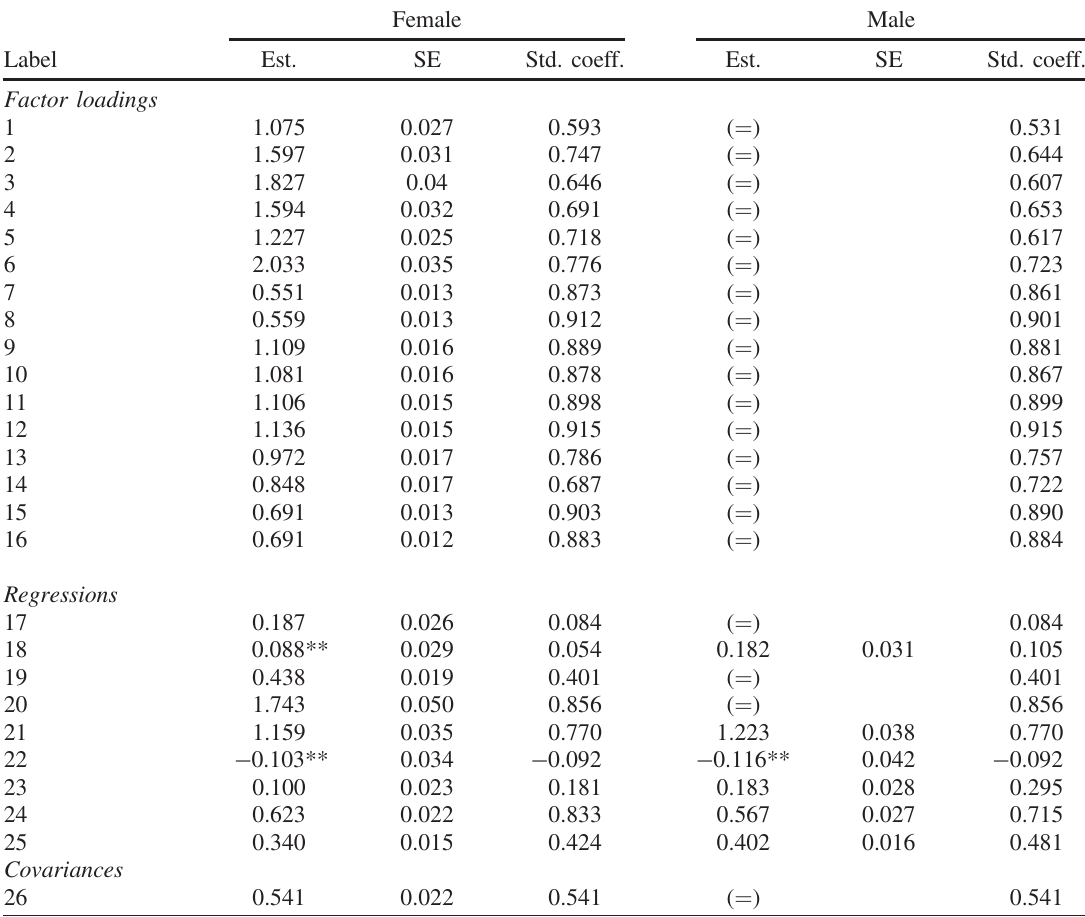
TABLE V. Factor and regression loadings for SEM. All paths are significant at the p < 0 . 001 level unless otherwise noted. ** indicates p < 0 . 01 . ( ¼ ) indicates that the path was constrained equal between groups. ( N ¼ 5541